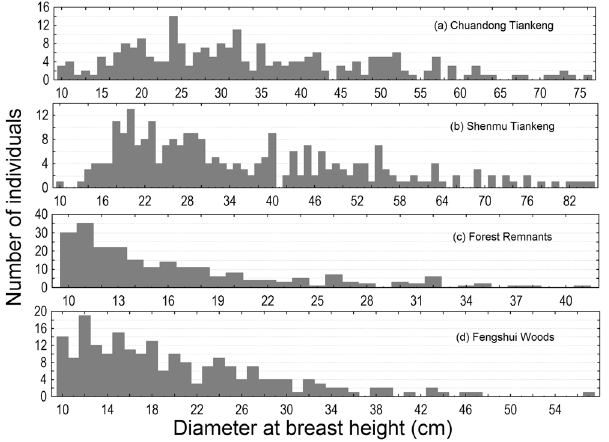
Figure 5. Histograms showing tree size distribution across habitats in the karst tiankeng